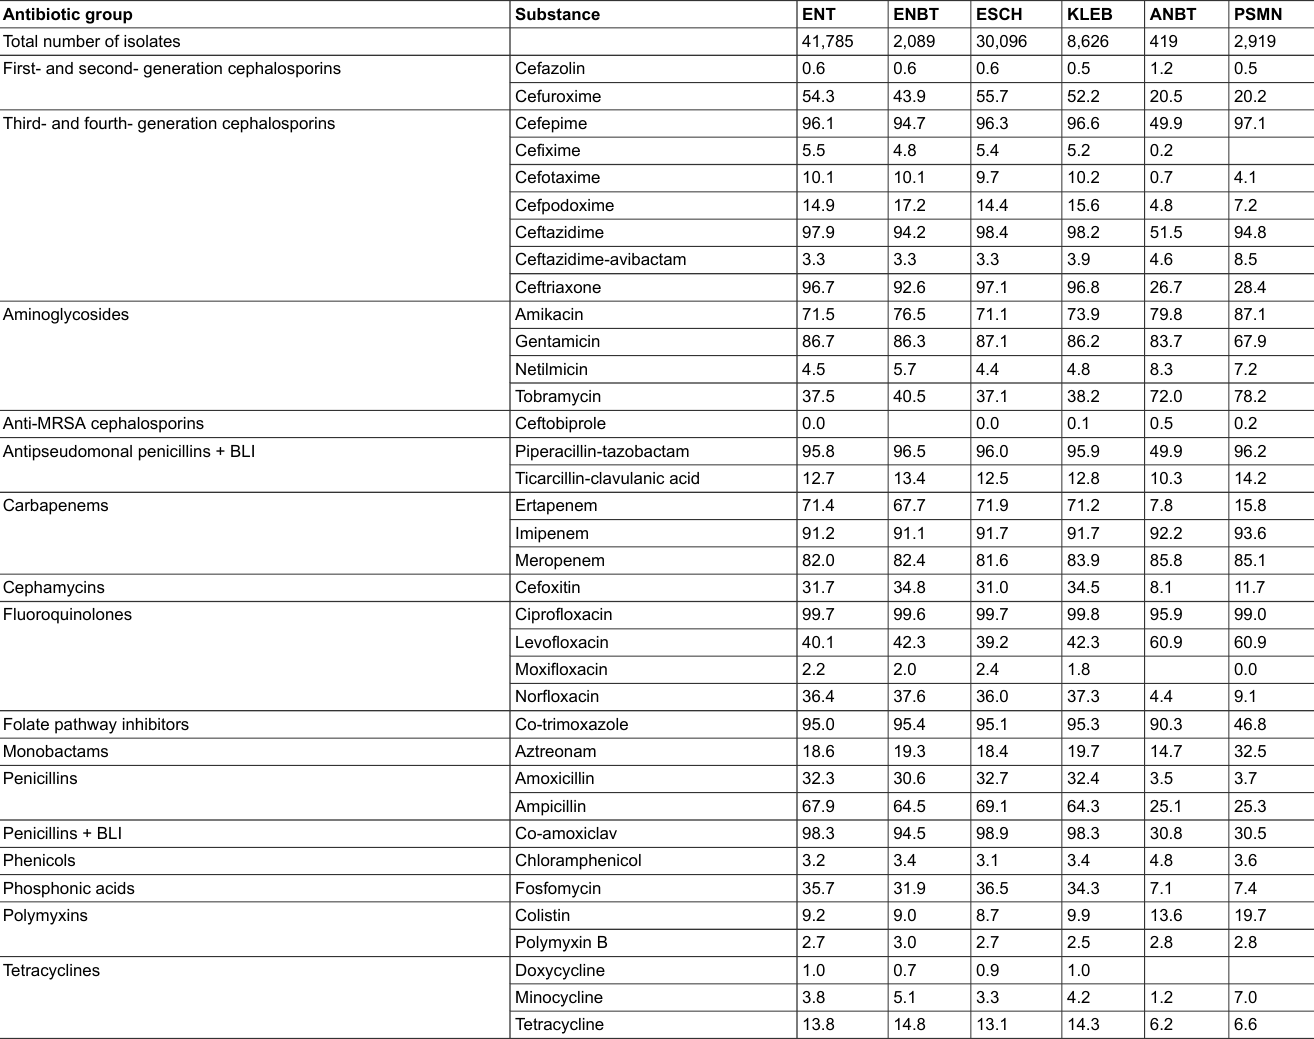
Table S1: Percentage of isolates that were tested for specific antibiotic substances. Antibiotic